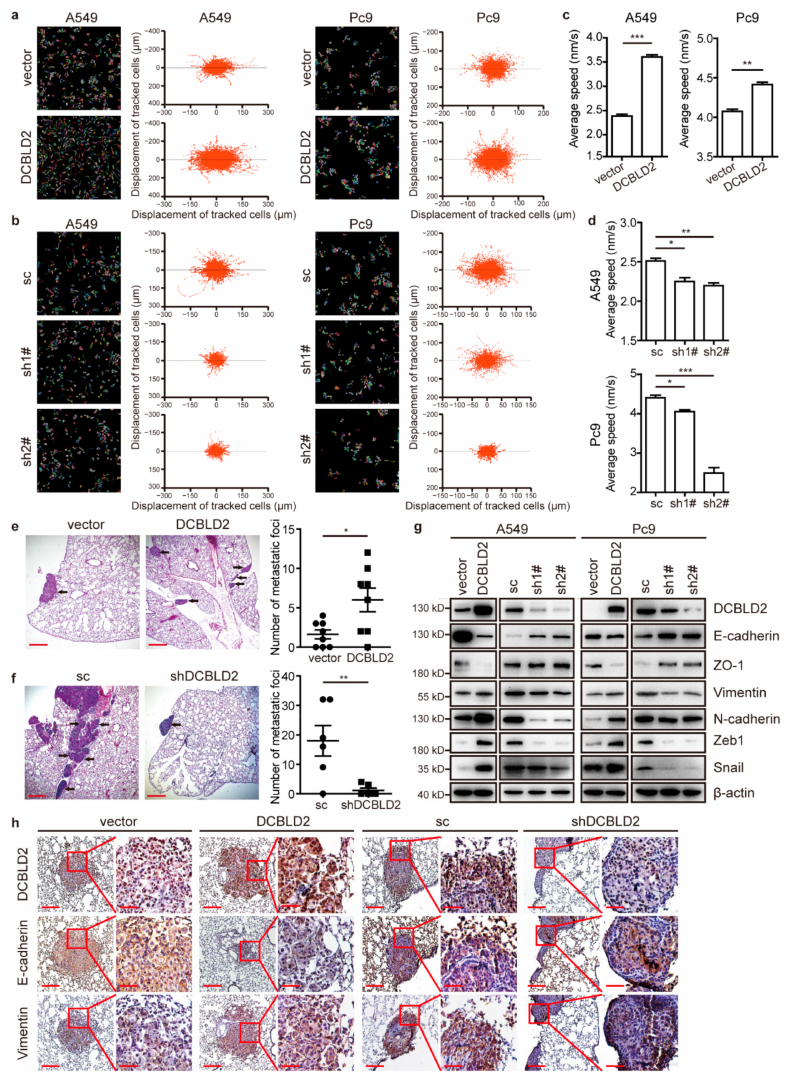
Figure 3. DCBLD2 induces migration and metastasis in LUAD. ( a – d ) Dynamic imaging analyses of cell migration in A549 and Pc9 cells. Cell migration was measured over 16 h by HCS. Representative images (left panel) and single-cell ultimate displacement (right panel) of A549 and Pc9 cells are shown in ( a , b ). The average speed was measured by Harmony software in ( c , d ). ( e ) A total of 1 × 10 6 empty vector or DCBLD2-overexpressing cells were inoculated into the right lungs of BALB/c nude mice ( n = 8 per group) to establish an orthotopic tumor xenograft model. Six weeks after inoculation, mice were sacrificed. The metastatic foci in the left lung were subjected to HE staining (left panel), and statistical analysis of the number of metastatic foci in the left lung is shown in the right panel. Scale bar: 400 µ m. ( f ) A total of 1 × 10 6 scramble control or shDCBLD2 A549 cells were inoculated in the right lung of BALB/c nude mice ( n = 6 per group) to establish an orthotopic tumor xenograft model. Eight weeks after inoculation, mice were sacrificed. The metastatic foci in the left lung were subjected to HE staining (left panel), and statistical analysis of the number of metastatic foci in the left lung is shown in the right panel. Scale bar: 400 µ m. ( g ) Western blot analysis of EMT markers in A549 and Pc9 cells. DCBLD2 was overexpressed or knocked down in cells, and western blot analysis of the expression of EMT-related proteins was performed. ( h ) Representative IHC images of the expression of E-cadherin and Vimentin in the primary lesion (right lung) of mice with orthotopic tumors derived from empty vector and DCBLD2-transfected cells or scramble control and shDCBLD2 cells. Scale bar: 200 µ m (left), 50 µ m (right). * p < 0.05, ** p < 0.01, *** p < 0.001, t